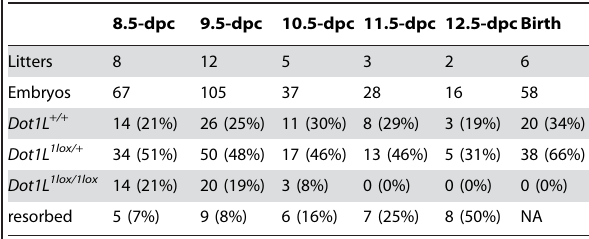
Table 1. Dot1L deficiency results in embryonic